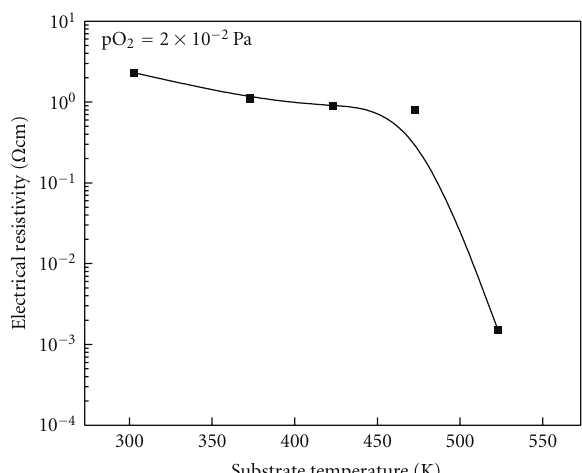
Figure 7: Dependence of electrical resistivity of Ag-Cu-O films on the substrate temperature.